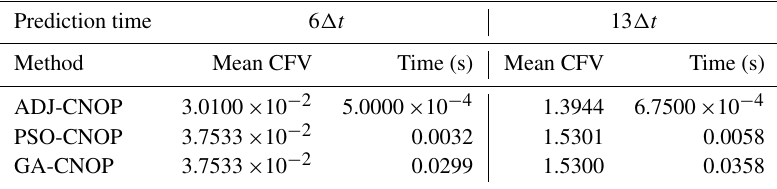
Table 6. Analysis of CFV and average computational time by different methods.